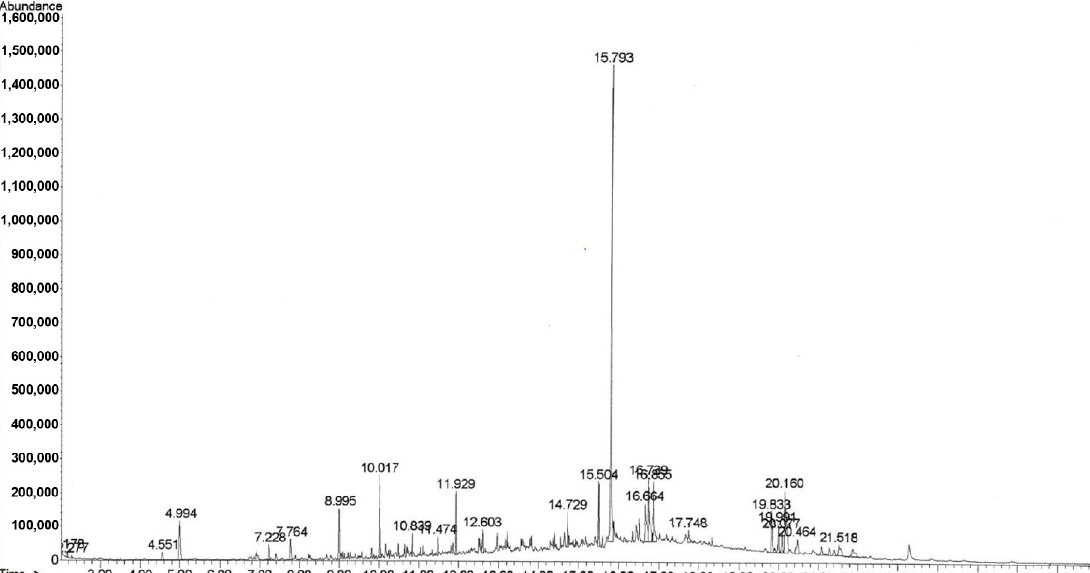
Figure 6. GC-MS mass spectra for sludge pyrolytic oil. Table 8. GC-MS analysis of sludge pyrolytic oil.